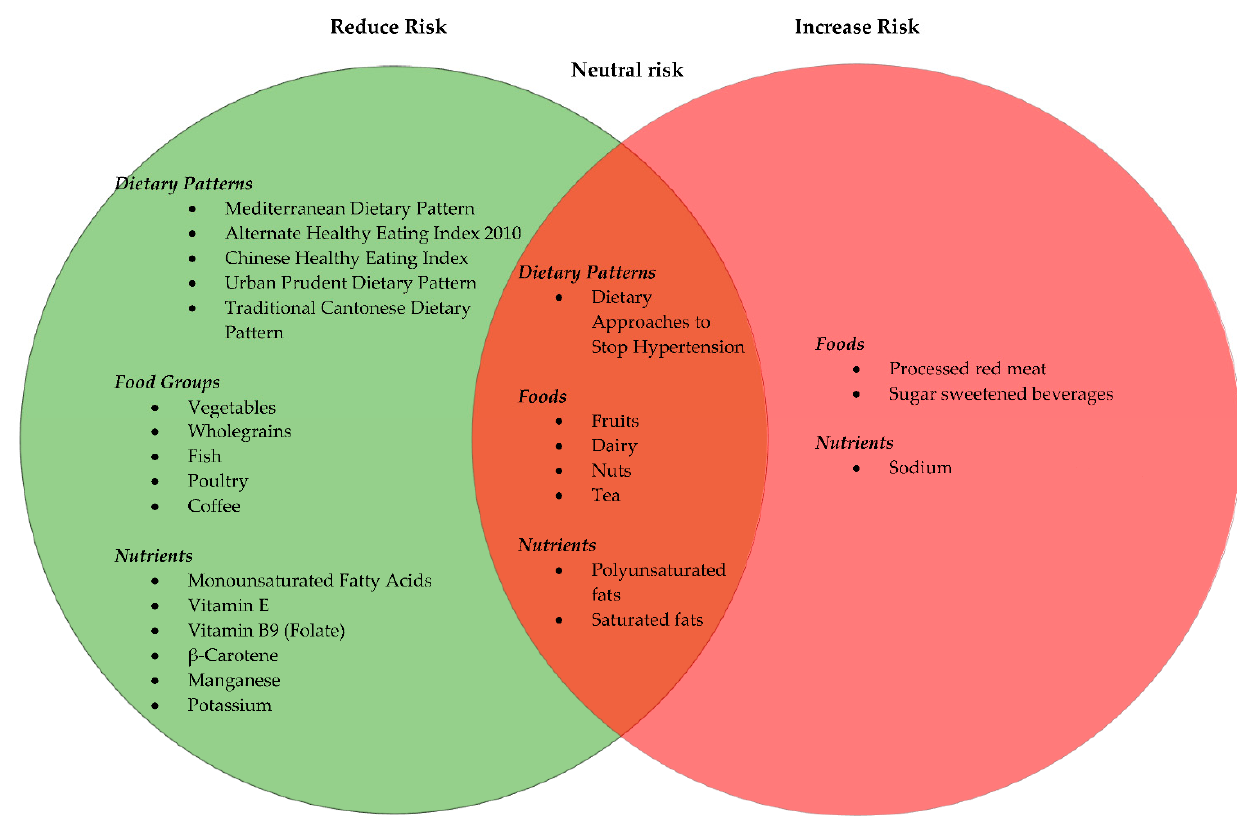
Figure 2. A summary of dietary patterns, food groups and nutrients and the associated risk with hepatocellular carcinoma based on observational studies included in this systematic review.